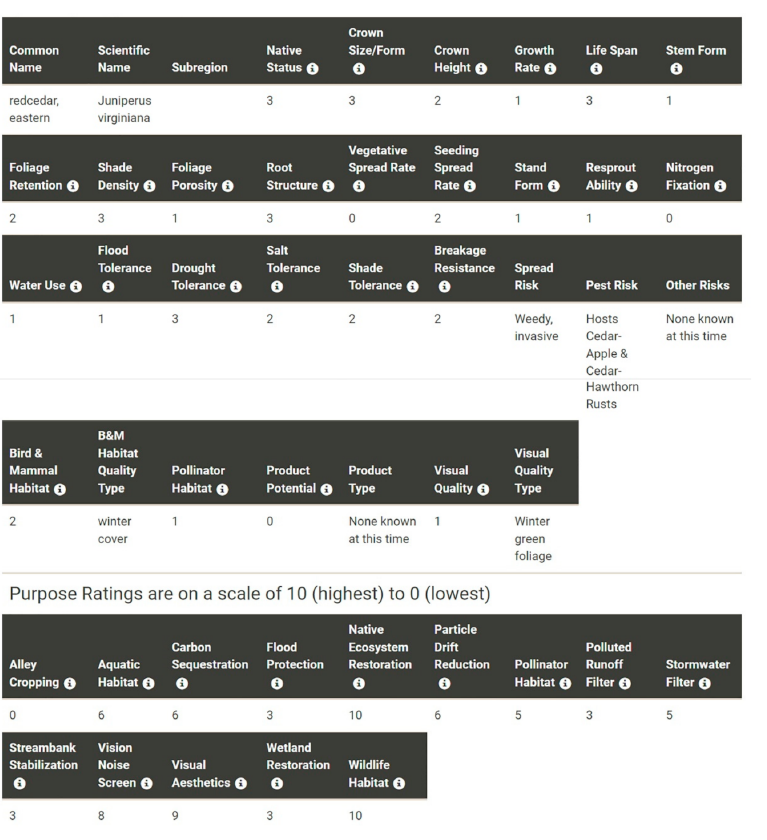
Figure 5. The Individual Species Attribute module provides a summary of a species attributes and purpose